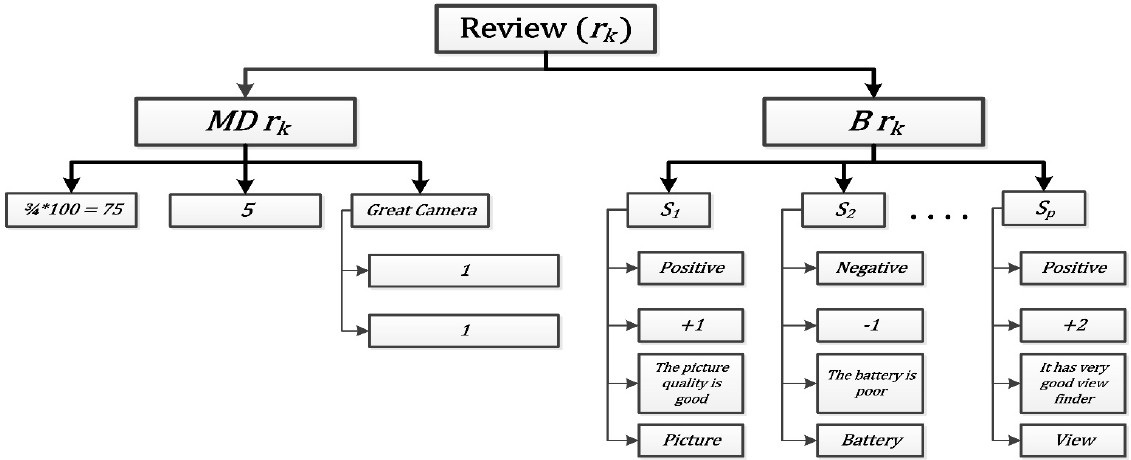
Figure 3. Review tuple based on the example review in Figure 2.